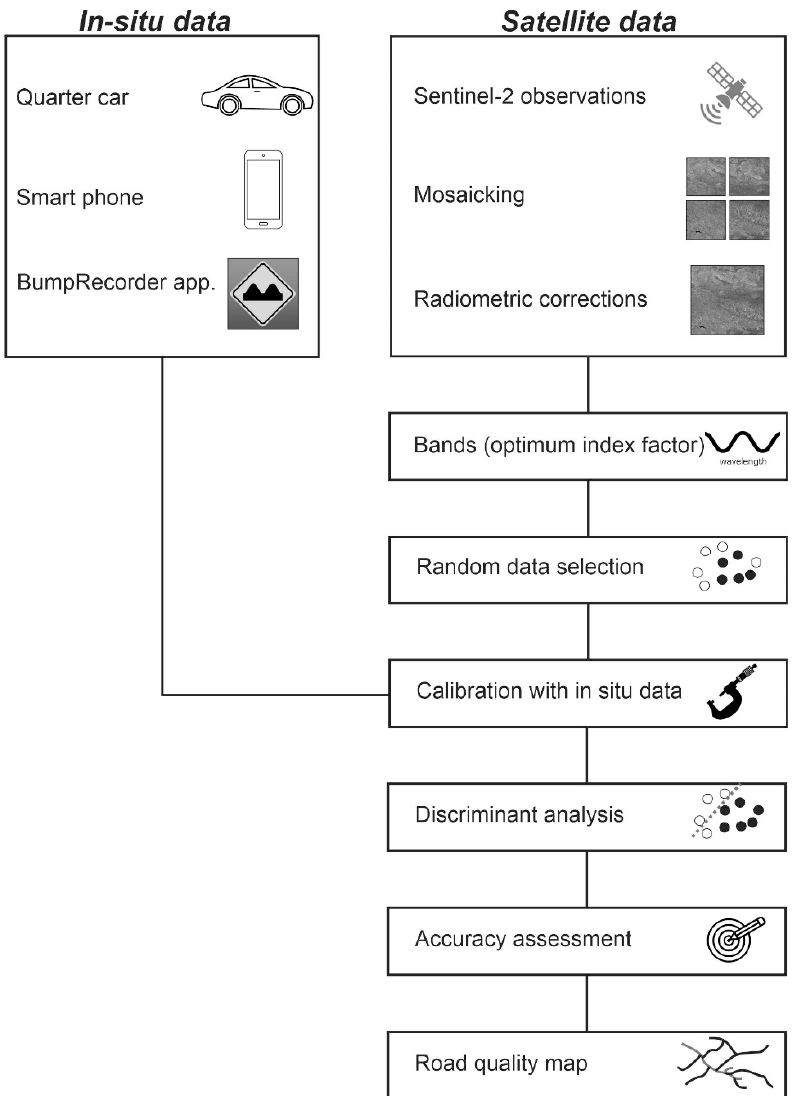
Figure 4. Workflow of road quality mapping based on in situ and satellite datasets.